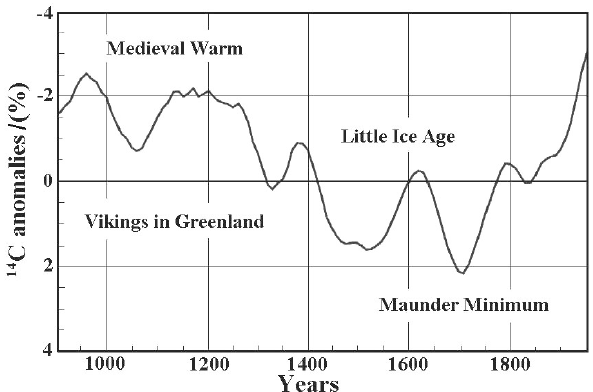
Fig. 1. The change of CR intensity reflected in radiocarbon concen- tration during the last millennium. The Maunder minimum refers to the period 1645–1715, when number of sunspots was very small. According to Svensmark